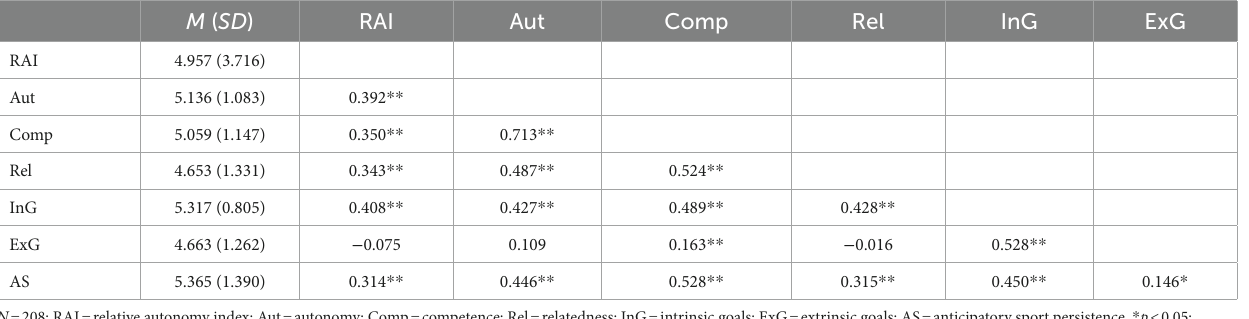
TABLE 2 Descriptive statistics and correlations for study